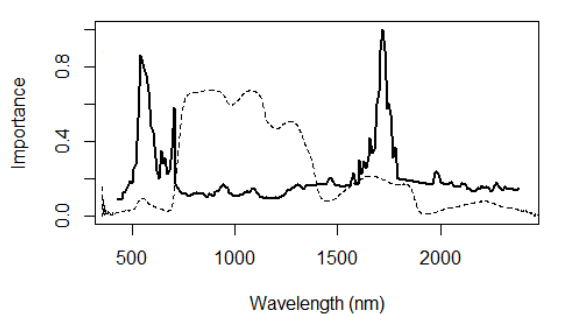
Figure 1. Variable importance (solid line) for the Random Forests classification model and a Eucalyptus leaf reflectance spectrum measured in the laboratory (dashed